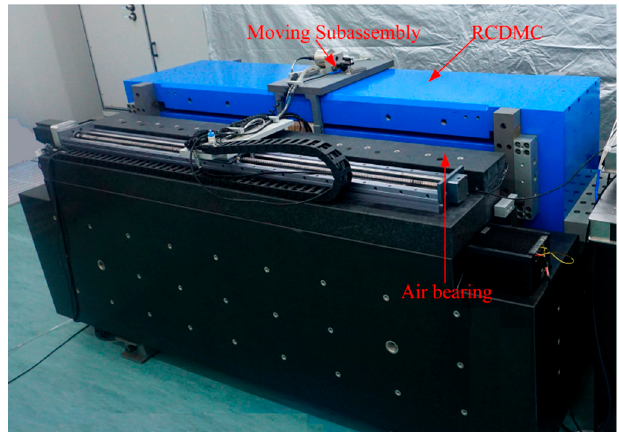
Figure 12. Prototype of RCDMC assembled in a horizontal ULF vibration exciter. Reproduced with permission from [19], IEEE, 2019.